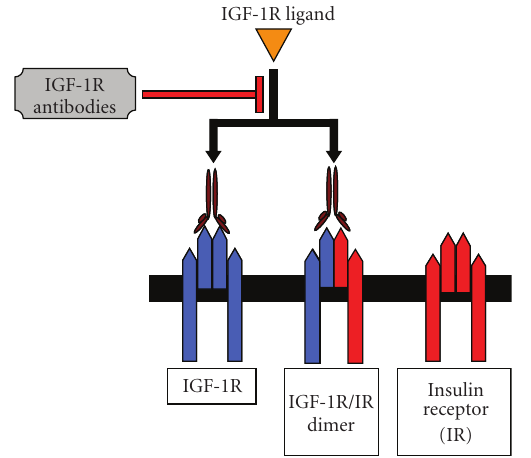
Figure 3: Insulin-like growth factor 1 receptor (IGF1R) system. Ligands (IGF-I, IGF-II, and insulin) bind to the receptors (IGF1R, IGF-2R, and insulin receptor [IR]) with di ff erent a ffi nity. The IGF1R and IR possess tyrosine kinase activity. Binding of the IGF- 1 ligand to IGF1R leads to a conformational modification of the receptor and activation of the tyrosine kinase subunit. Each receptor triggers complex and di ff erent intracellular signaling cascades.